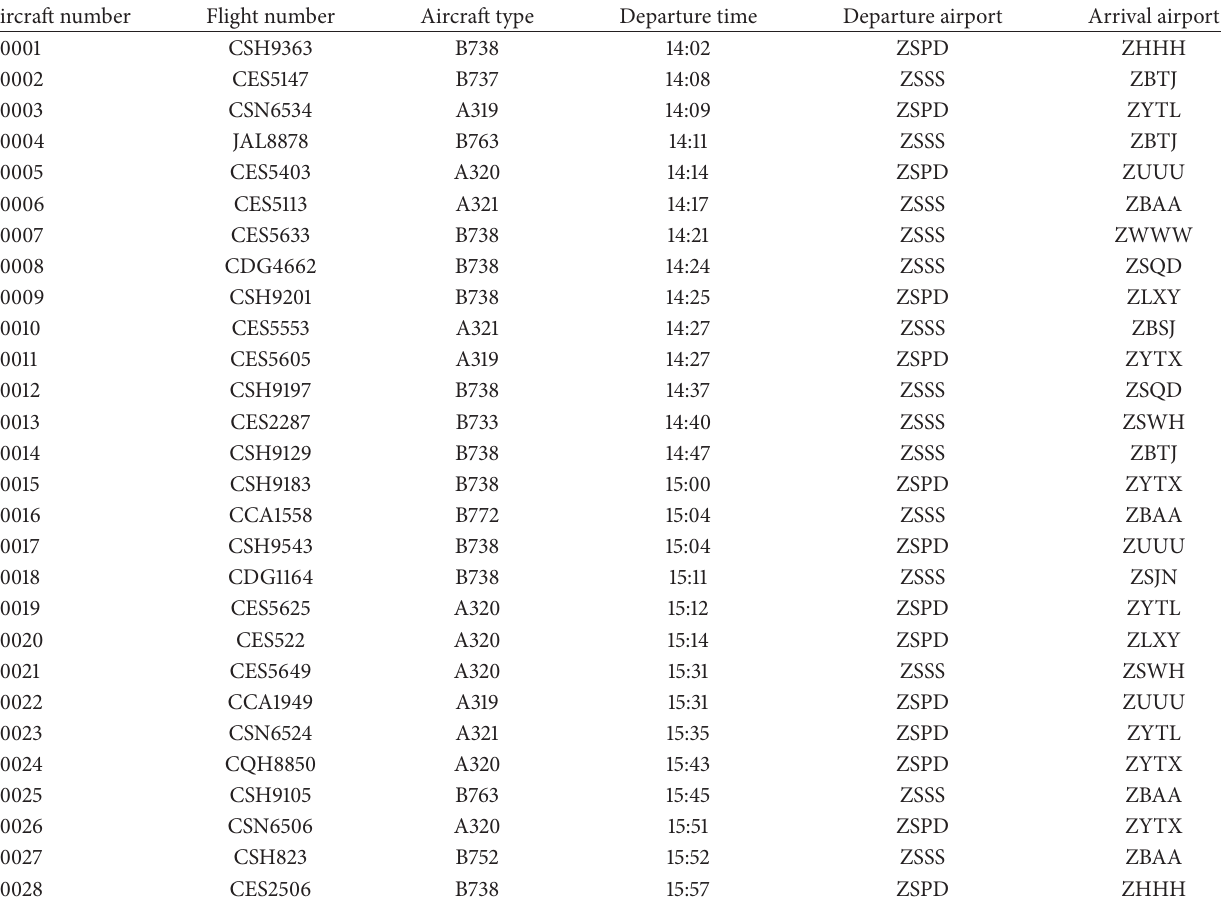
Table 1: Flight information for aircraft queues in two hours.